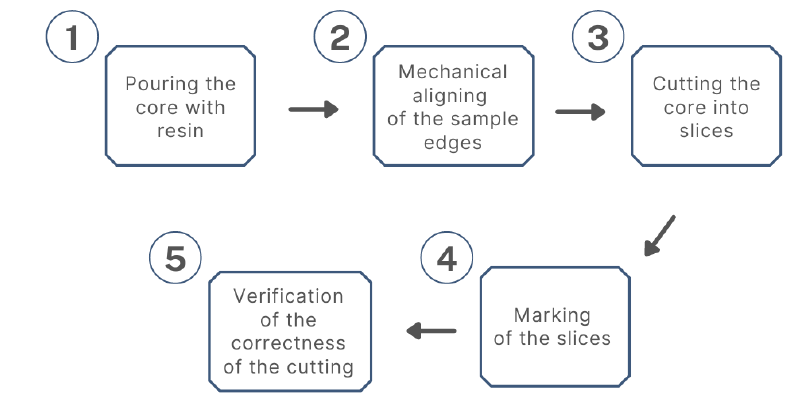
Figure 2. Scheme of manual preparing the